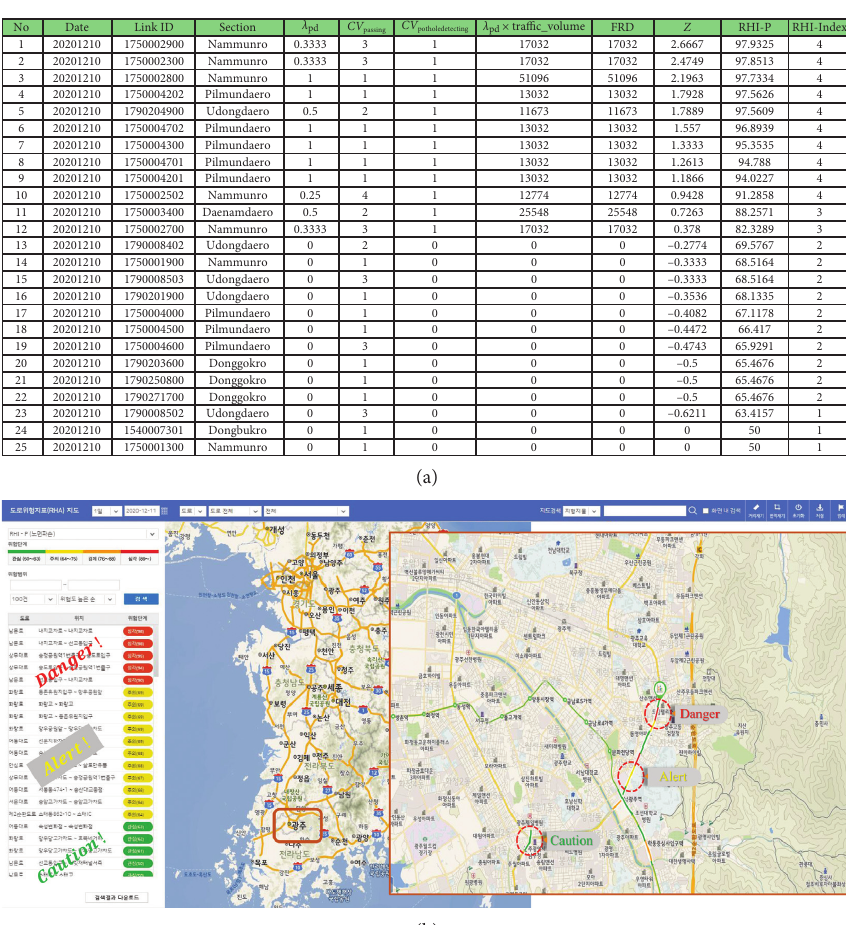
Figure 6: Road hazard index results in Gwangju. (a) Road hazard index results in text format. (b) Road hazard index results in GIS format.